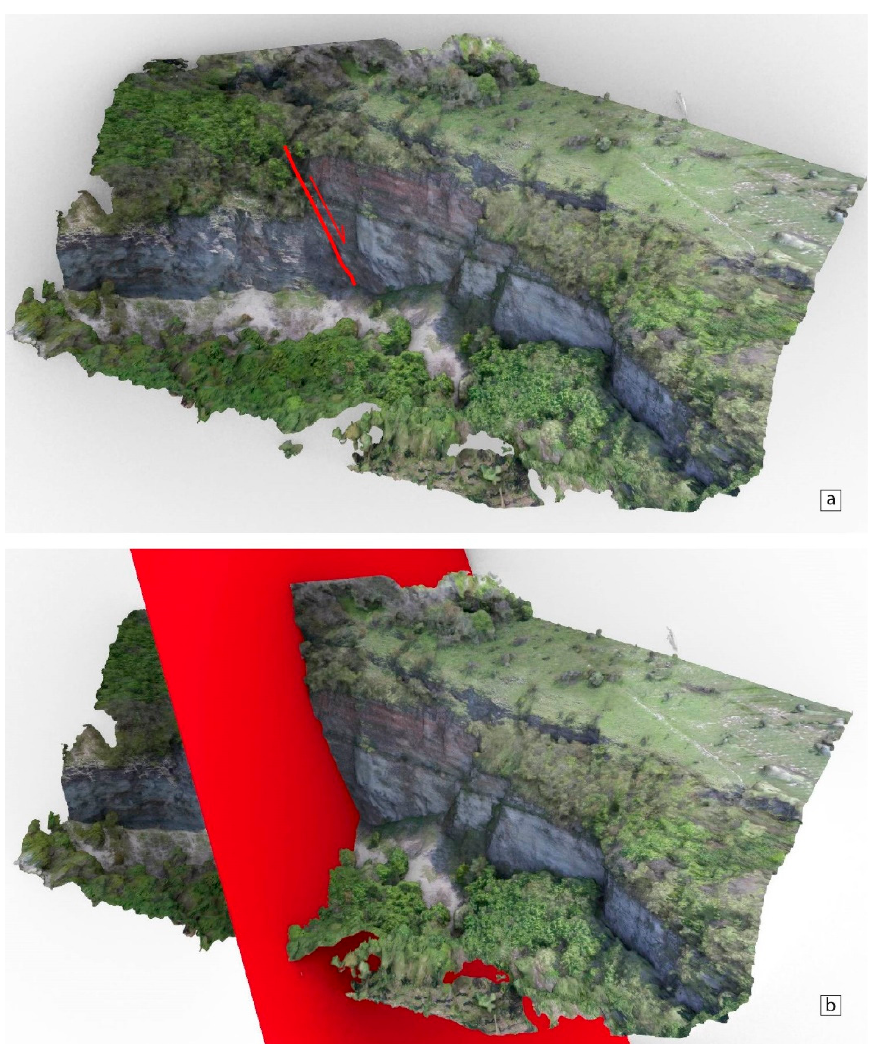
Figure 7. ( a ) Virtual outcrop from the drone survey picture composition of site B3 (see Figure 2 for location) built using Agisoft Metashape. ( b ) Fault plane interpreted using Rhinoceros.